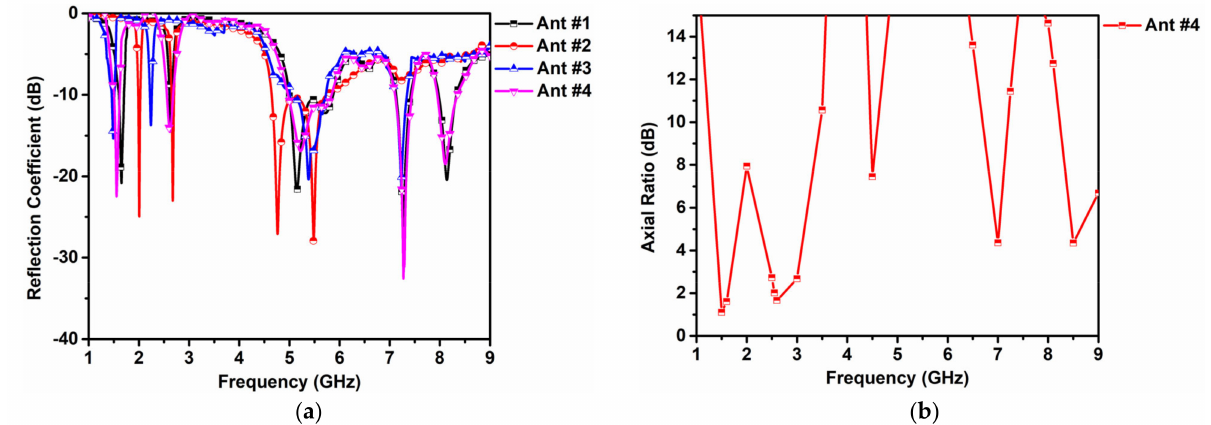
Figure 4. Single element pentaband reflection coefficient of Ants #1 to #4. ( a ) Reflection coefficient ( b ) axial